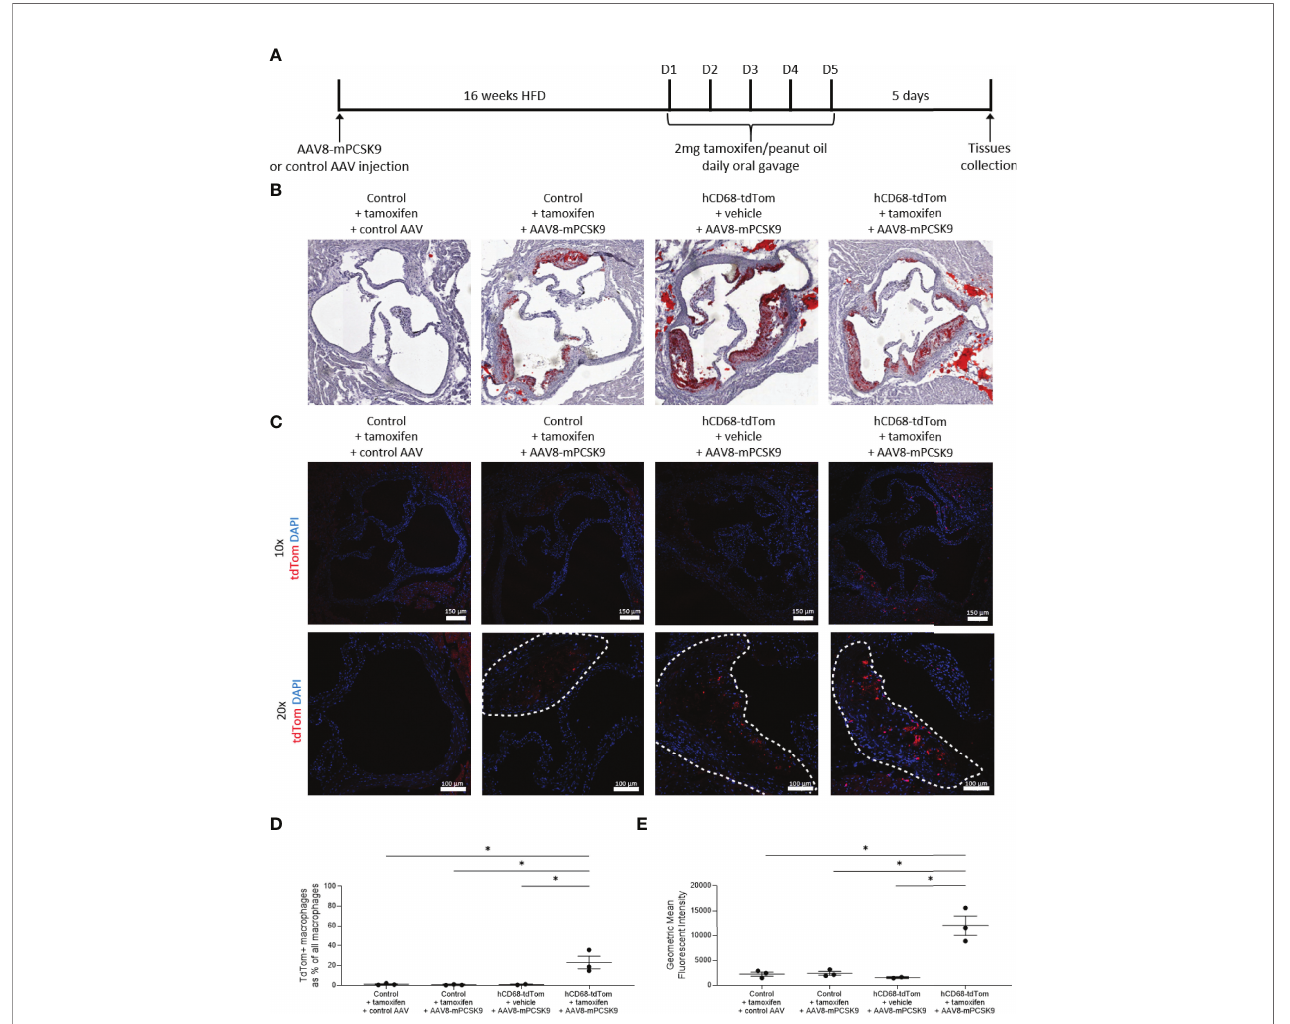
FIGURE 7 | The hCD68 promoter driven inducible Cre recombinase targets recruited macrophages in the atherosclerotic lesion. (A) Timeline of the inducible PCSK9 atherosclerosis model and induction of Cre recombinase in hCD68-CreERT2 mice. (B) Representative images of Oil Red O staining of the aortic roots con fi rm the induction of atherosclerotic plaques in the AAV8-mPCSK9 injected groups. (C) Representative immuno fl uorescence images of endogenous tdTomato expression in the aortic roots at 10x (whole aortic root) and 20x (plaque close-up with plaque edges outlined with the dashed line) magni fi cation with DAPI in blue and tdTomato in red; scale bar = 150 µm in 10x images and 100 µm in 20x images. (D) Frequency of tdTomato-expressing aortic macrophages as a proportion of all aortic macrophages with the corresponding mean fl uorescent intensity of total aortic macrophages in (E) ; one-way ANOVA (* = p <